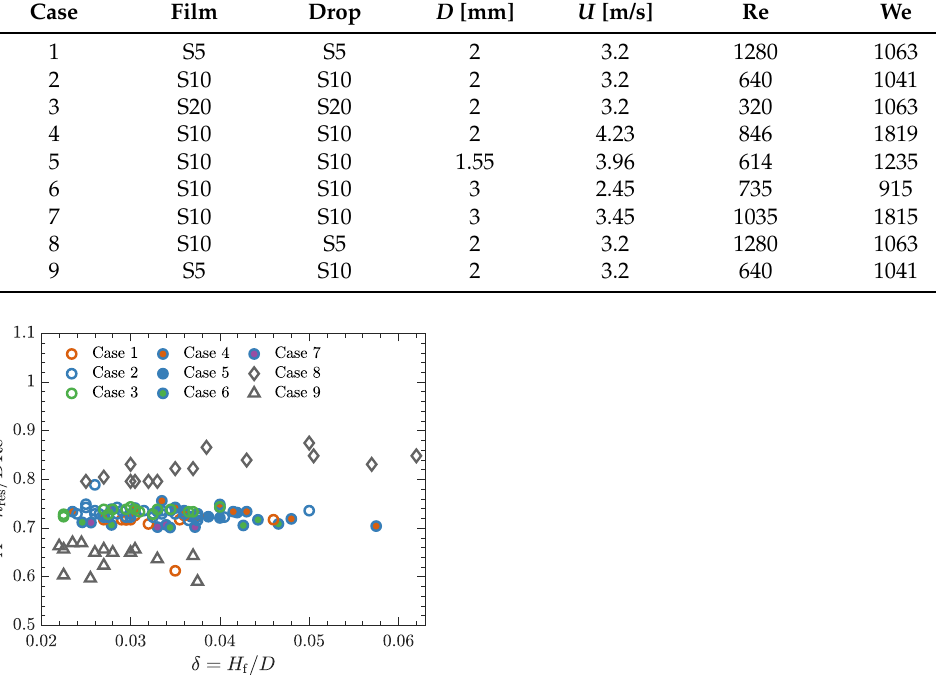
Figure 5. Residual film thickness. Measurement data for the parameter A defined in (6) for various viscosities ν , impact velocity, U drop diameter, D and initial film height H f . The cases are defined in Table